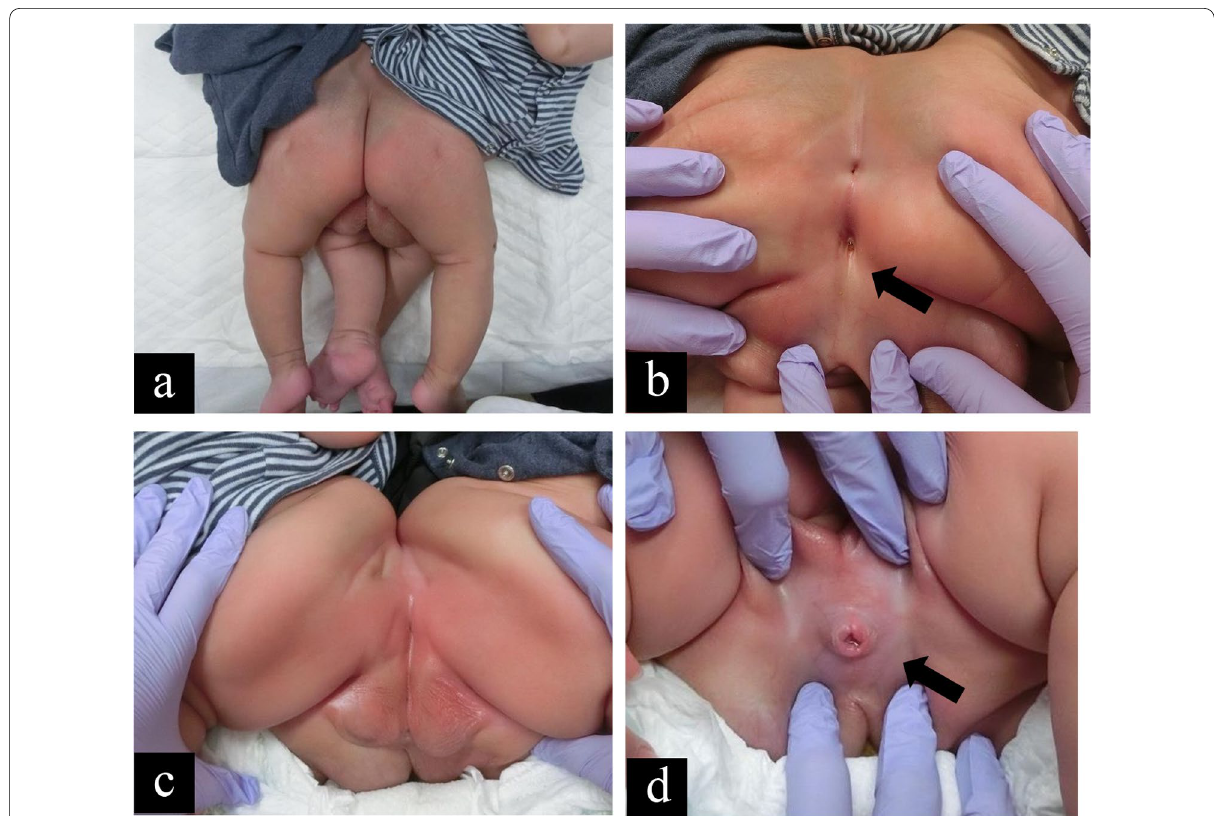
Fig. 1 Physical exams before the twins underwent surgical separation. a General appearance, b fused anus with one anal aperture, c fused scrotum with four testes, d fused penis with one